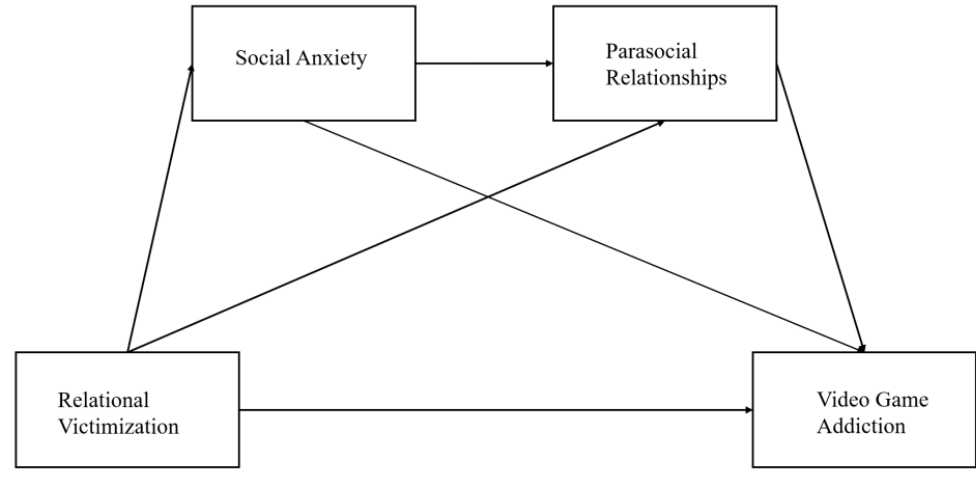
Figure 1. The hypothetical figure of social anxiety and parasocial relationships between relational victimization and video game addiction.